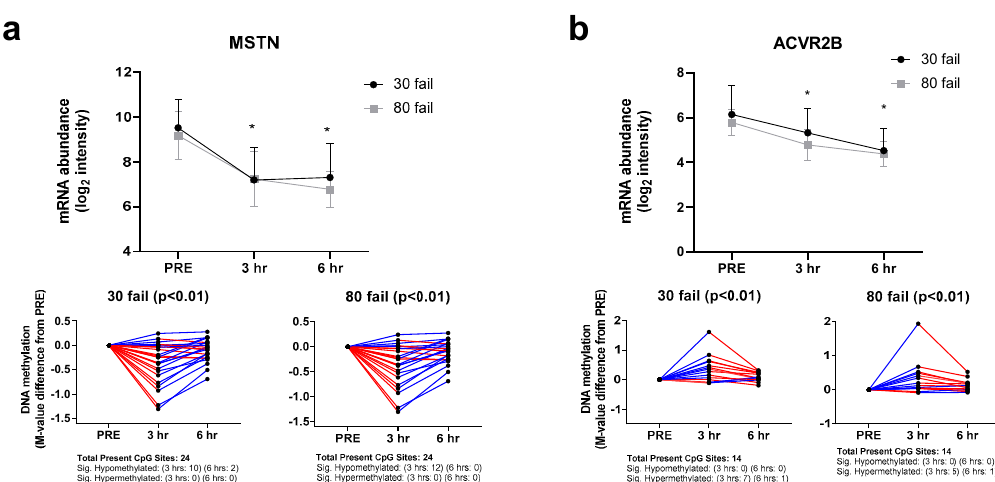
Figure 2. MSTN and ACVR2B mRNA and DNA methylation responses. mRNA and methylation responses of myostatin (MSTN, panel ( a )) and Activin A Receptor Type 2B (ACVR2B, panel ( b )), which is the cognate receptor for myostatin. Notably, resistance exercise (regardless of load) downregulated these mRNAs, whereas only ACVR2B showed several CpG sites being significantly hypermethylated by resistance exercise. Symbol: *, indicates mRNA at 3 h or 6 h post-exercise was significantly downregulated. Other note: CpG sites are depicted as M-value changes from PRE, where red coloration indicates a directional change downward, and blue indicates a directional change upward.